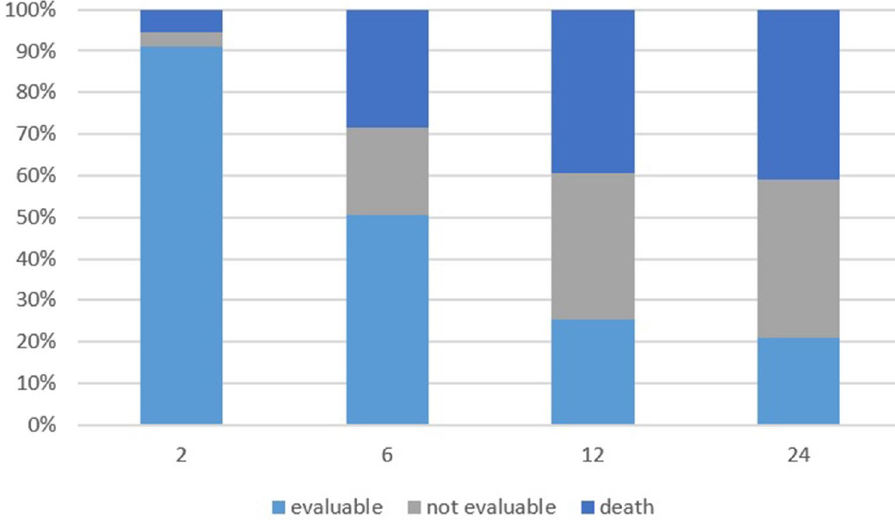
Figure 1. Drop-out trend during the study period.